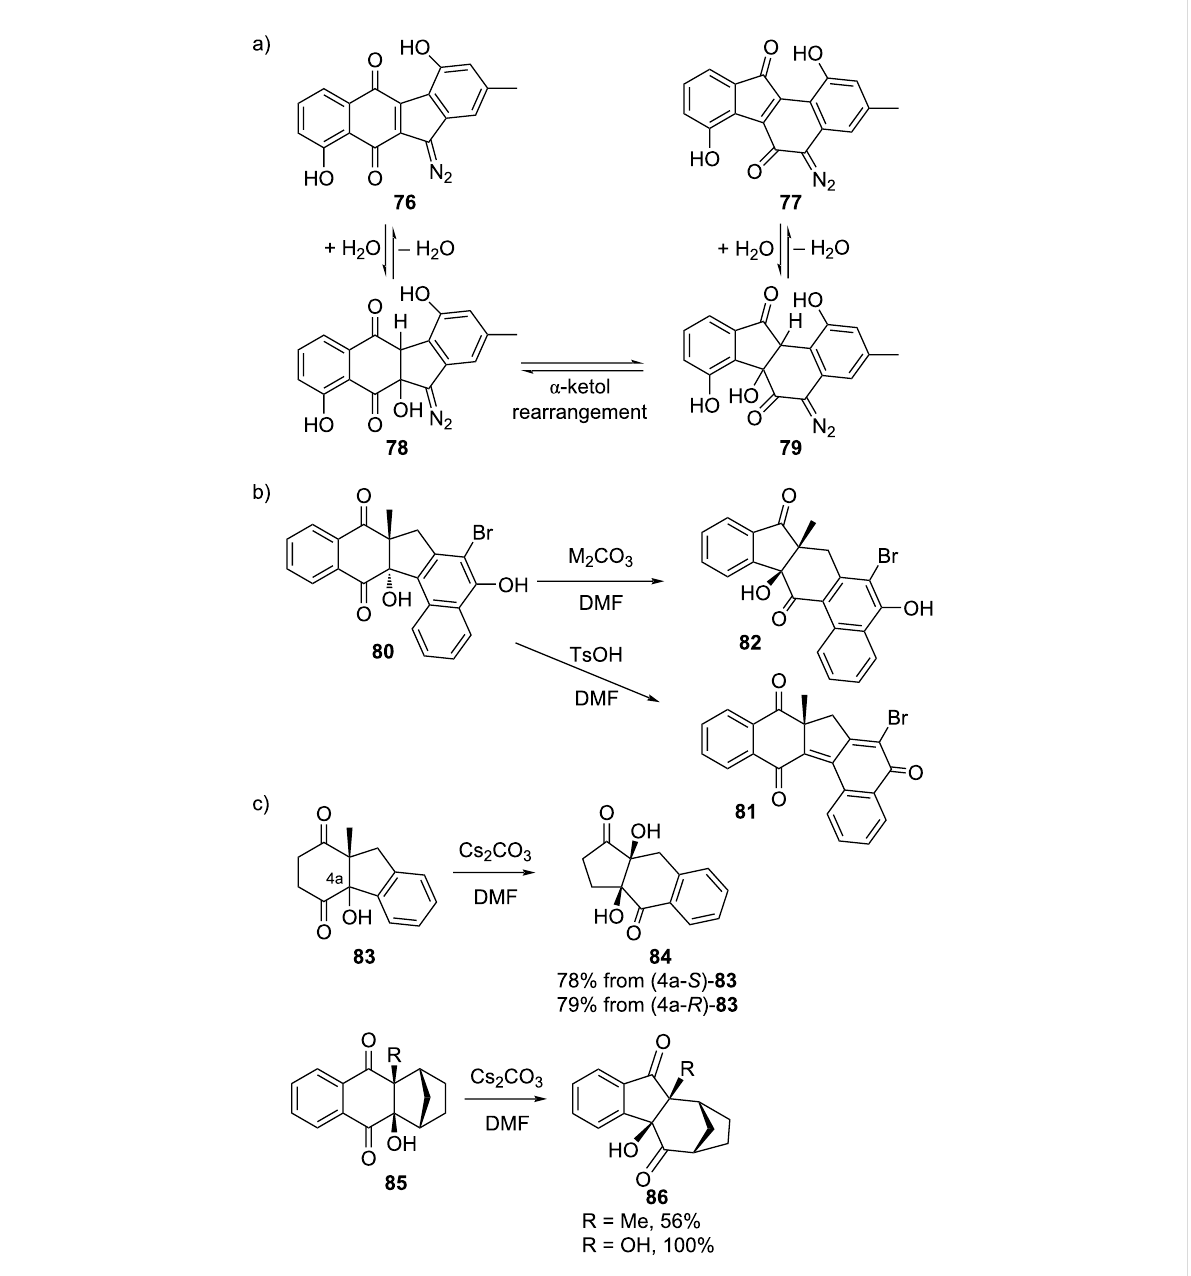
Figure 16: Hypothetical interconversion of natural products prekinamycin ( 76 ) and isoprekinamycin ( 77 ) and chemical models of their proposed α -ketol intermediates. a) The natural products are believed to interconvert biologically by a reversible sequence of hydration–rearrangement–dehydra- tion. b) α -Ketol rearrangement of 80 , an analogue of proposed intermediate 78 , occurs with base (M = K or Cs), but dehydration to 81 occurs with acid. c) Substrate scope of similar Cs 2 CO 3 -catalyzed α -ketol rearrangements.